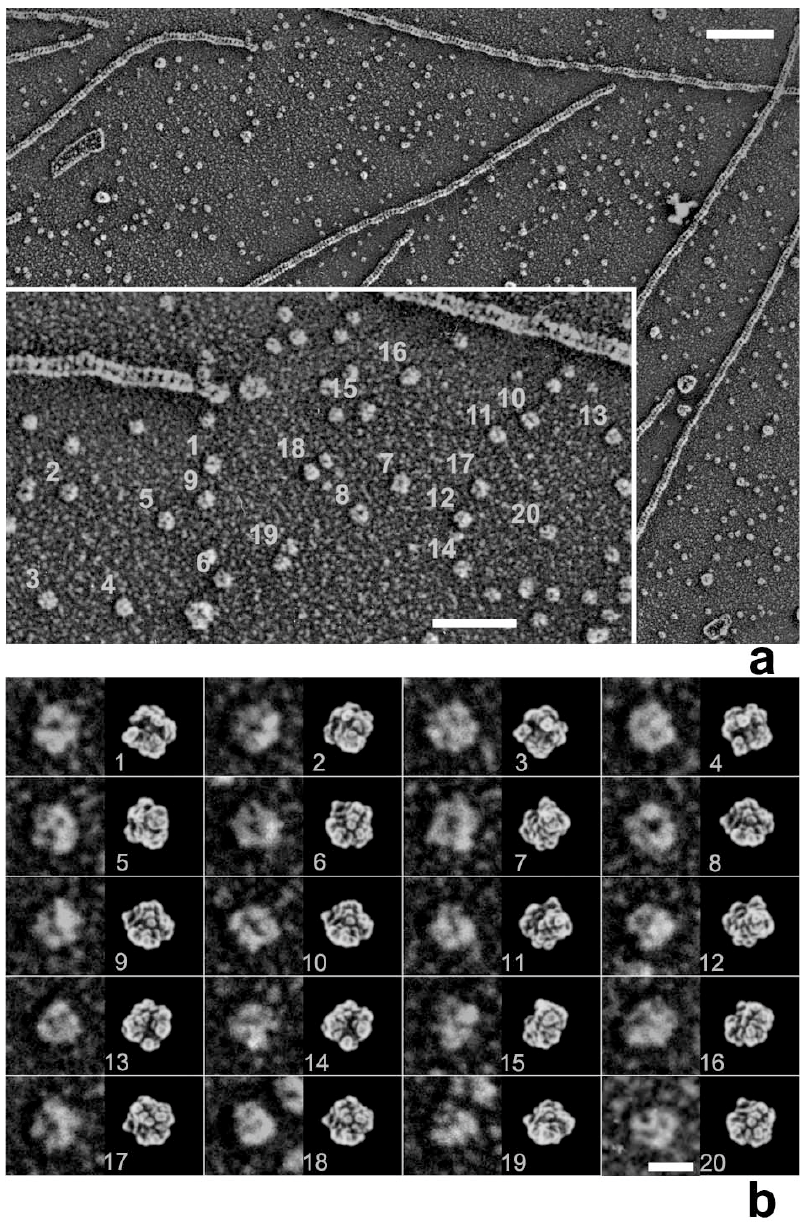
Figure 1. ( a ) Freeze-replica images of actin filaments with protomer particles in the background. Inset shows a part of the field with some numbered particles; ( b ) Gallery of numbered particles magnified and aligned side by side (left) with likely views (right) of the atomic model of actin to compare the subdomain arrangement in each particle. Note that the shadowed metal grains are fine enough so that ca. 1 nm-width clefts between subdomains are well recognized, suggesting the actual resolution of QFDE replica specimens. Scale bars indicate ( a ) 100 nm, (inset) 50 nm and ( b ) 10 nm.